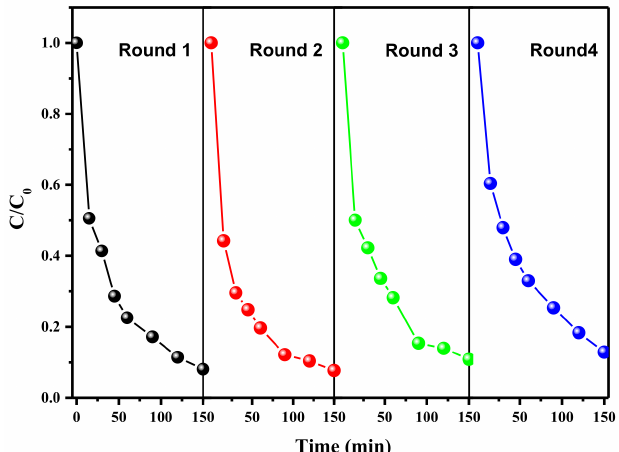
Figure 5. Degradation of AR 73 in multiple uses of FeNi-Pd@CN catalyst (AR 73 200 mg/L; catalyst dosage: 2 g/L; FA: 46.6 mmol/L; air; 200